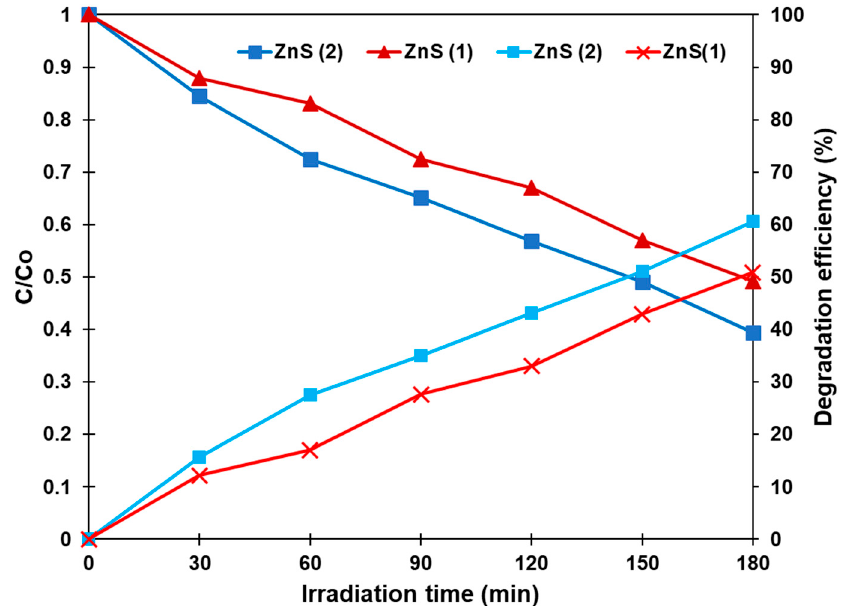
Figure 6. Methylene blue (MB) concentration change (C/C 0 ) and degradation efficiency (%) over samples ZnS(1) and ZnS(2) during their irradiation for 180 min. Before illumination, each reaction mixture was kept in the dark for 30 min.